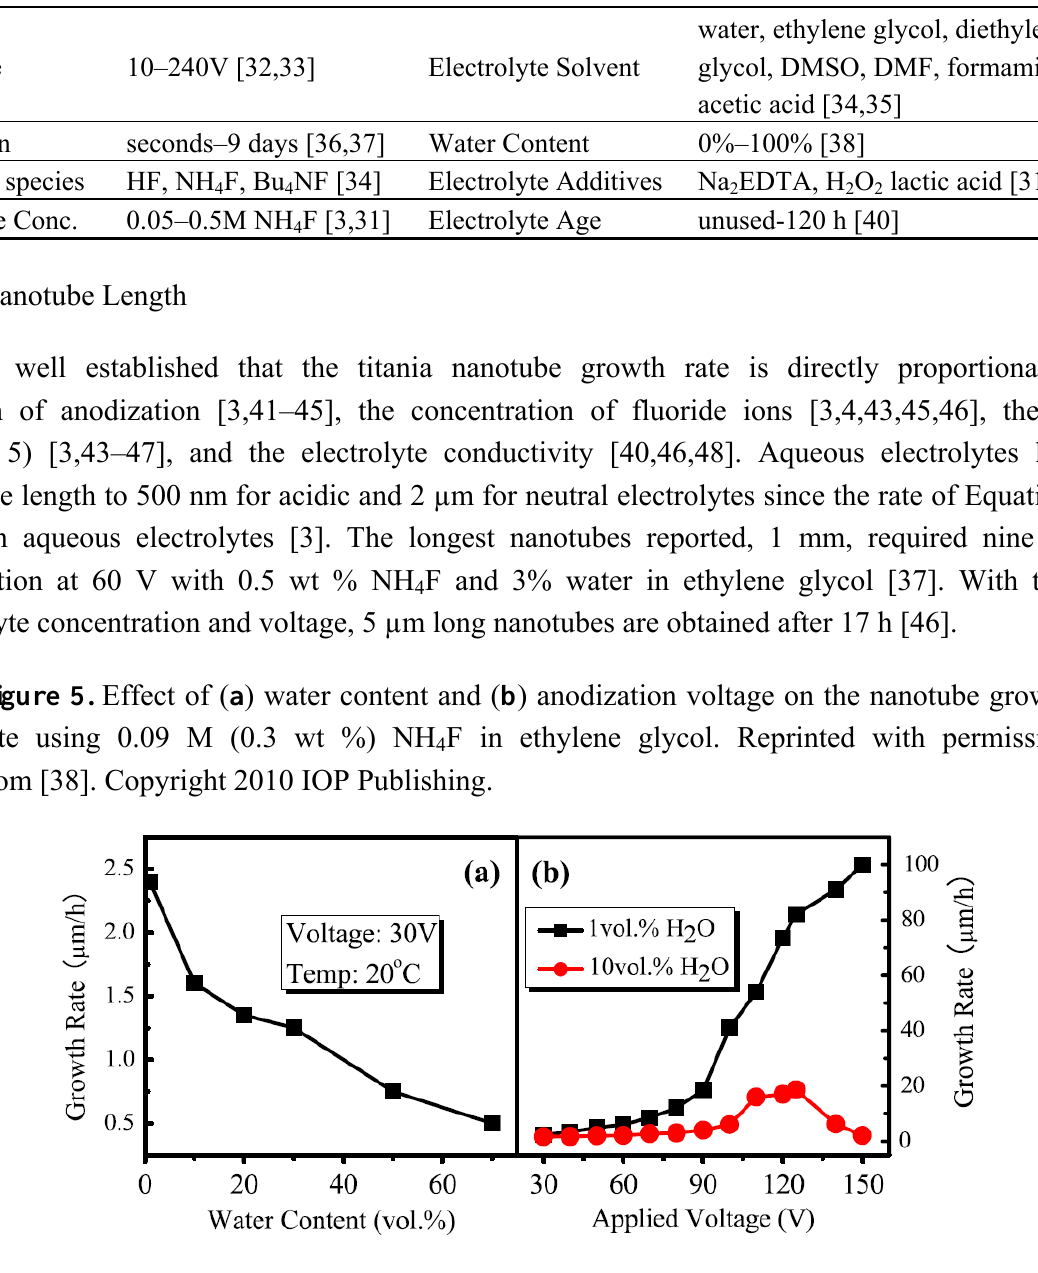
Table 1. Range of conditions used to control the nanotube morphology. Electrolyte age refers to its previous use for titanium anodization.